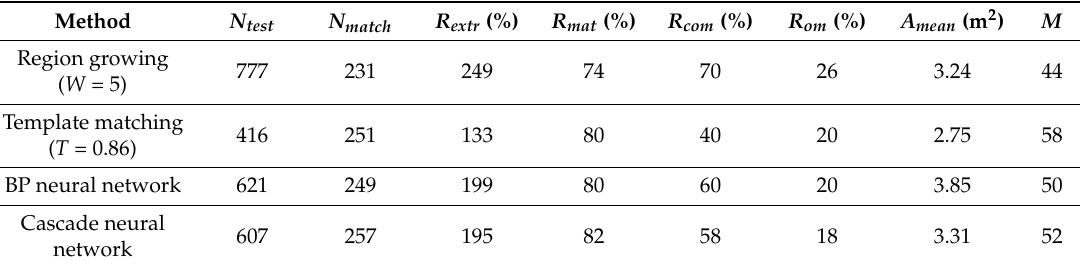
Table 3. Detection results for test area 3